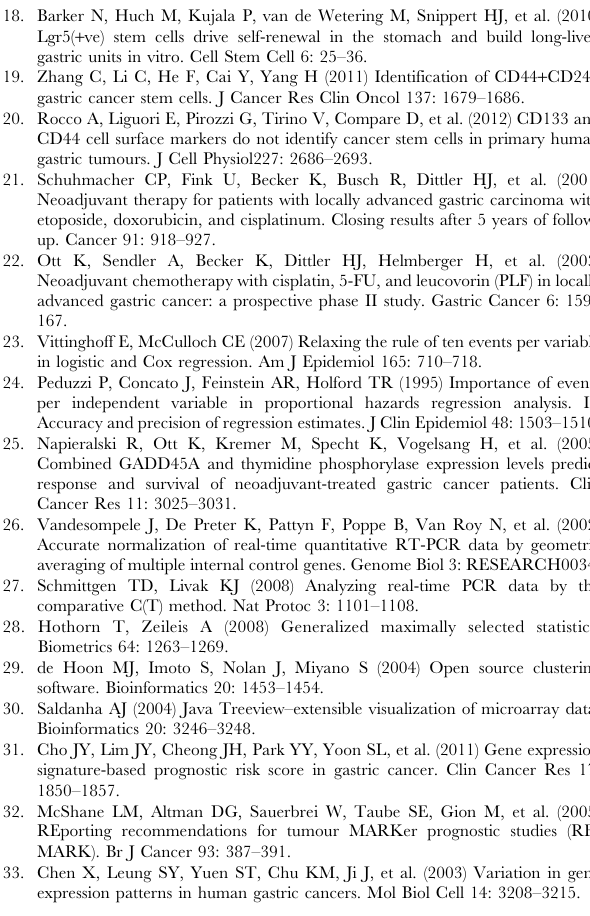
Table S5 Relative survival rates based on the dichotomised risk score (own data). Table S6 Multivariate Cox regression data for the publically available dataset. Table S7 Relative survival rates based on the dichotomised risk score (public